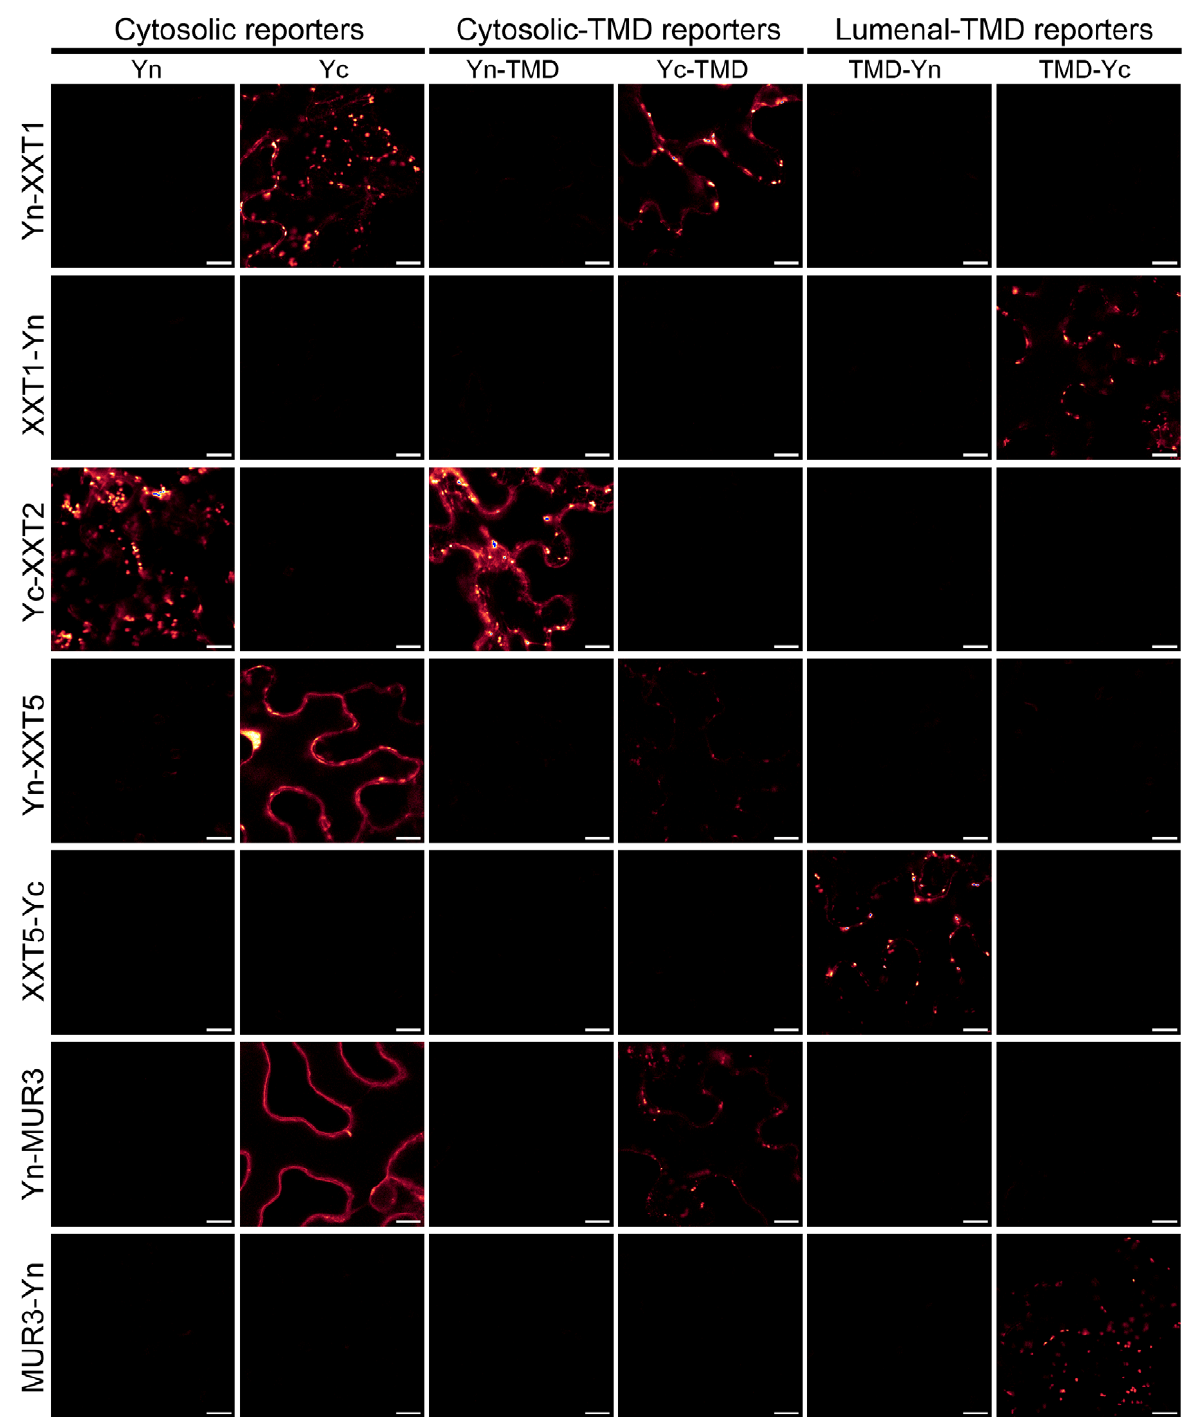
Figure 7. GO-PROMTO analysis of enzymes involved in the xyloglucan biosynthetic pathway. All proteins were fused to GO-PROMTO tags in the N-terminus. Additionally XXT1, XXT5 and MUR3 were fused to Yn or Yc at the C-termini. In all cases, the N-terminal of the proteins was found to localize to the cytosol by only reacting with the cytosolic GO-PROMTO reporters, concurrent with bioinformatic predictions. Furthermore, C- terminal fusions of MUR3, XXT5 and XXT1 showed Golgi lumenal localization. These fusion proteins were transiently expressed in Nicotiana benthamiana . Observation was carried out by CLSM at 3 DPI. Scale bars, 10 m m. At least two individual experiments were performed for each combination with the similar results. All of the images were processed identically by using Adobe Photoshop CS3.0 Extended v10.0.